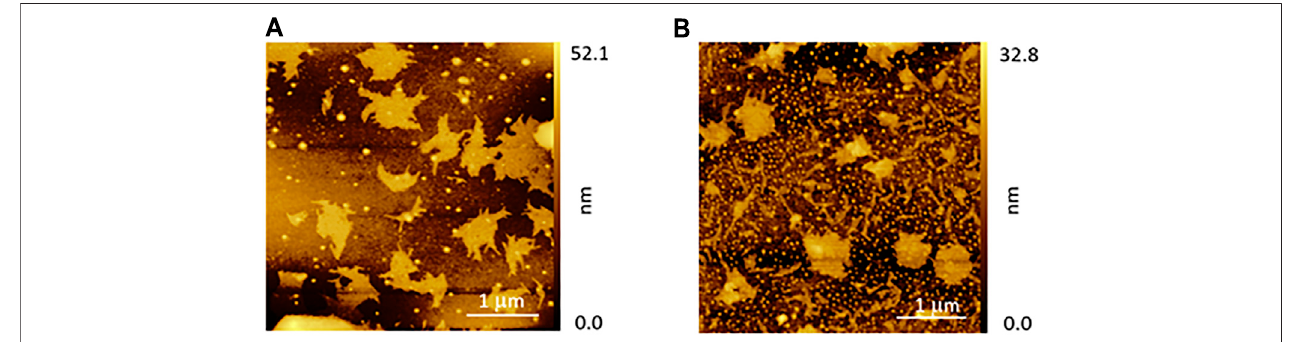
FIGURE 4 | AFM morphologies of the (D)ZnP(-) fi lm as a function of time: (A) as deposited and (B) after about 100 h with the sample taken in ambient conditions.